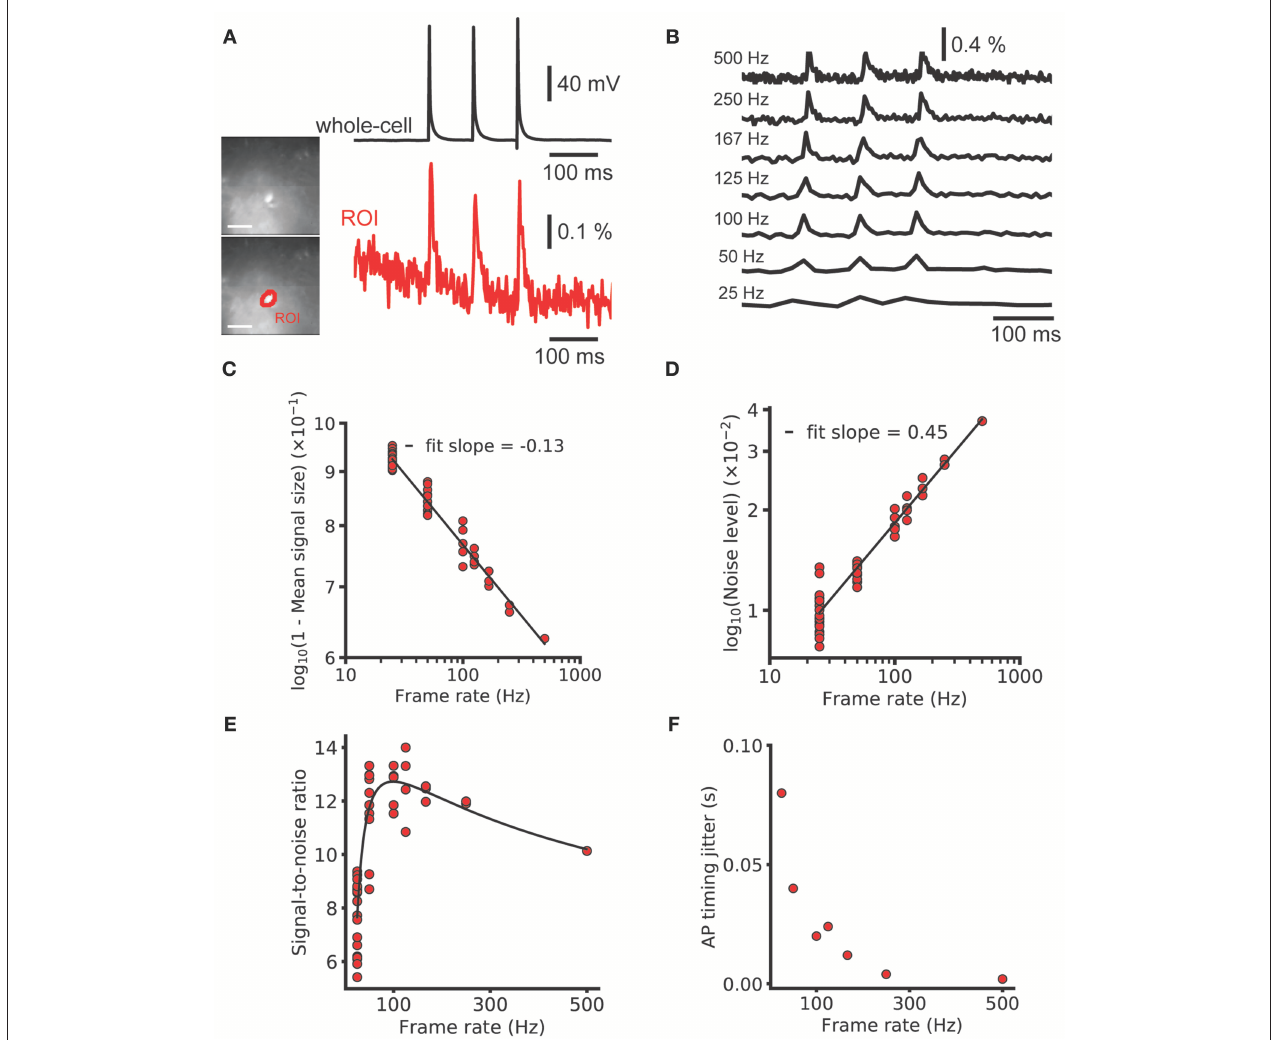
FIGURE 5 | Effect of frame rate on SNR and spike timing estimation. Decreasing the imaging rate in wide-field imaging reduces the temporal accuracy and AP shape information but increases the SNR. (A) Image of a brain slice from sparse GEVI mouse obtained at 500Hz frame rate (80 recording from cell body (black) and optical recording (red). Average of nine trials. (B) A 500Hz 1 F/F trace with 3 single-spike transients and down samples by averaging. Signal size, noise level and AP timing estimation accuracy all decrease with mean downsampling. (C,D) Power law fits to 1—signal size and the noise level. The noise level scales approximately with the square as expected from Poisson statistics. (E) The signal to noise ratio and power law fits plotted on linear axes. Fits give an optimal frame rate for spike detection SNR of 99Hz. Note that this curve is the result of the division of the log-log linear fits in (C,D) and not a fit to the plotted points. (F) The bounds on spike timing estimation for different frame rates. Fluorescence traces shown on inverted y